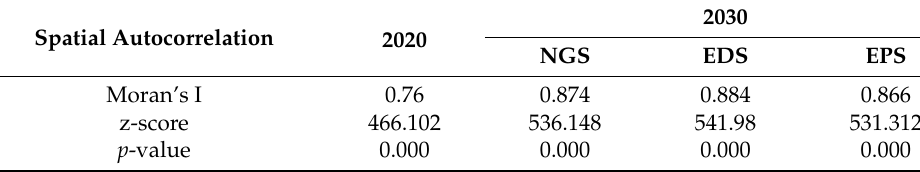
Figure 9. The land use area for each level of land use conflict. Table 3. Global Moran’s I index of